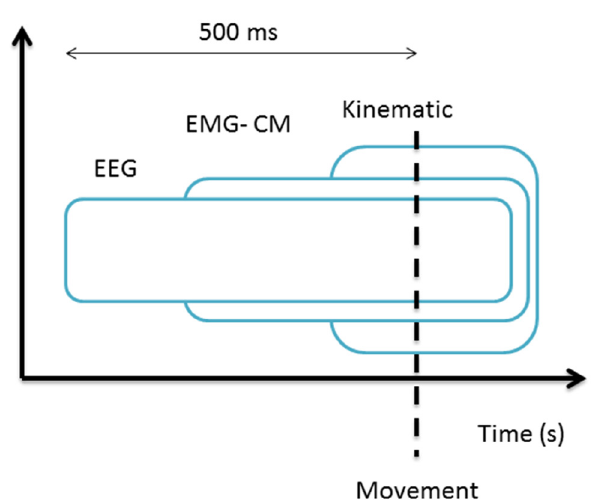
Figure 1. Expected prediction order. Different modules are used to predict a voluntary movement: EEG, EMG, Corticomuscular (CM) and a Kinematic module. Notice that movement might be predicted by the kinematic module, as happened in the case of rest tremor decreasing before a voluntary